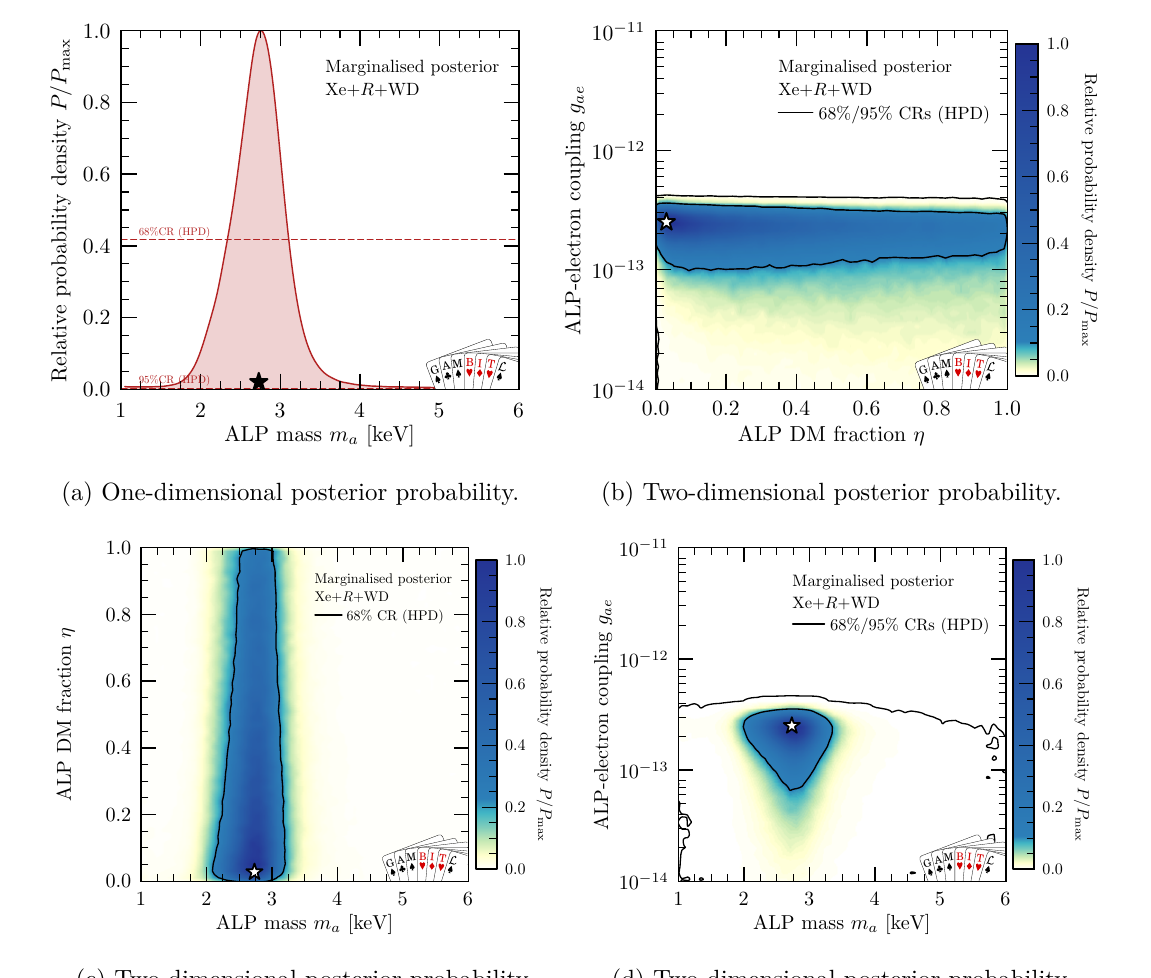
Figure 6. Posteriors with Xe + R + WD data for (a) the ALP DM mass, (b) the DM fraction and ALP-electron coupling, (c) the ALP DM mass and DM fraction and (d) the ALP DM mass and ALP-electron coupling. We should credible regions of highest posterior density (HPD), while stars indicate the best-fit